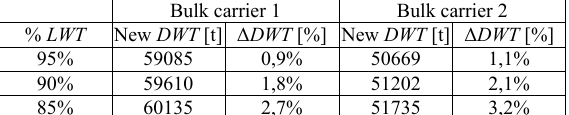
Table 9. Influence of DWT change on EEDI / EEXI